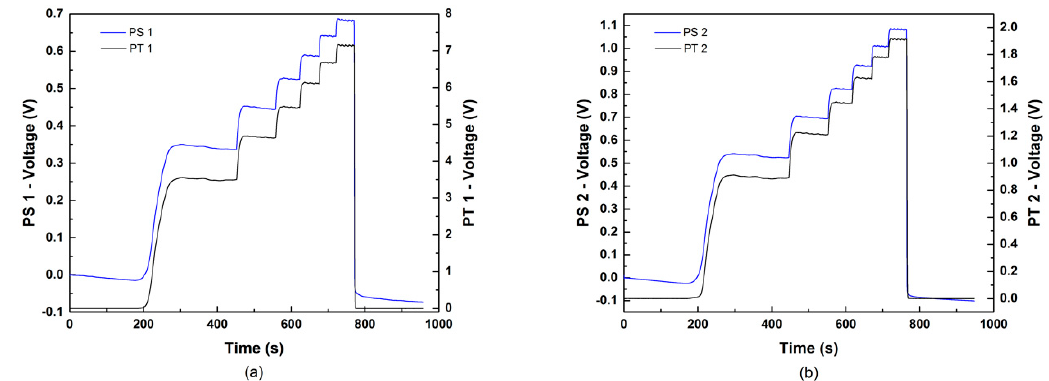
Figure 7. Time evolution of outputs (voltages) measured during the stepwise ramp in the piston velocity of the capillary rheometer fed with a low density polyethylene (LDPE) at 150 °C. ( a )—Piezoelectric (PS 1) and conventional (PT 1) transducers located upstream. ( b )—Piezoelectric (PS 2) and conventional (PT 2) transducers located downstream.